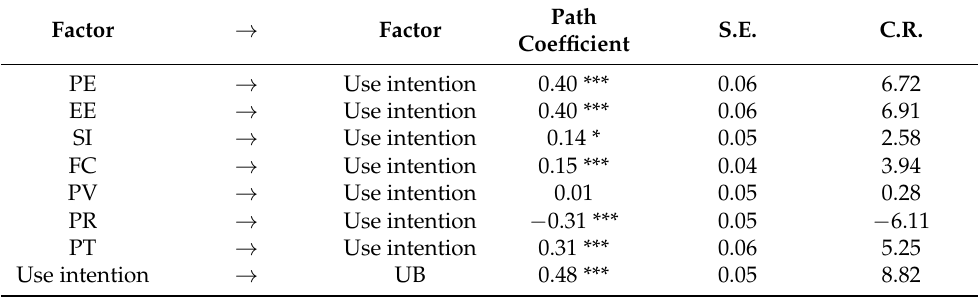
Table 9. Results of the path